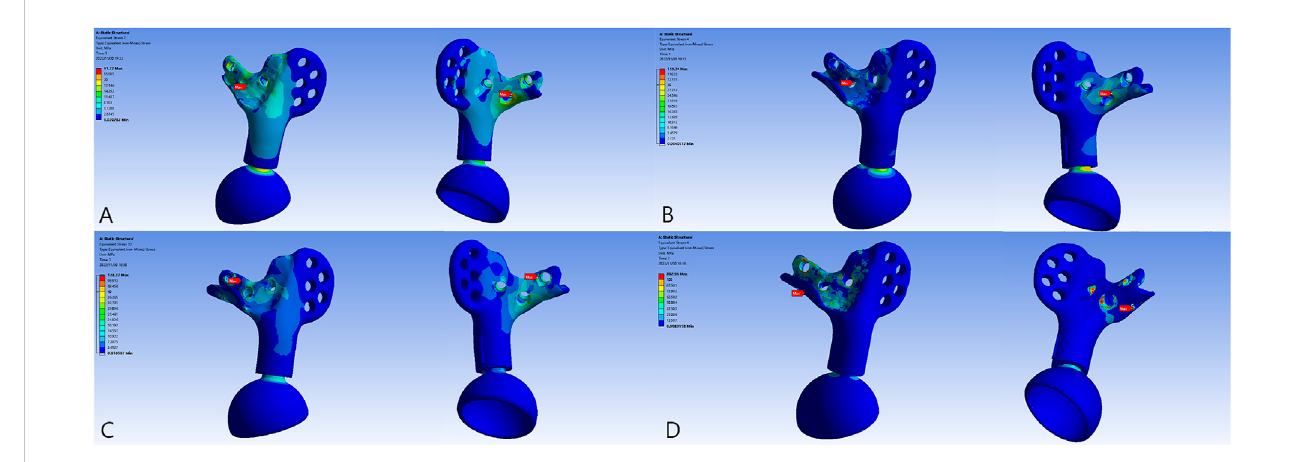
FIGURE 6 The von Mises force of the prosthesis and the force concentrated near the screw holes. (A) Model 1_B. (B) Model 2_B. (C) Model 3_B. (D) Model 3_E.